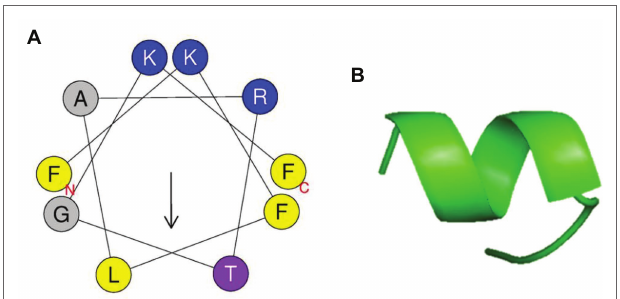
FIGURE 6 | Helical wheel projection and three-dimensional structure projection of PN5 peptide. Helical wheel projection of PN5 was generated using HeliQuest (http://heliquest.ipmc.cnrs.fr/cgi-bin/ComputParams.py) (A) . Simulations of the three-dimensional structures of peptides generated using PyMOL (B)